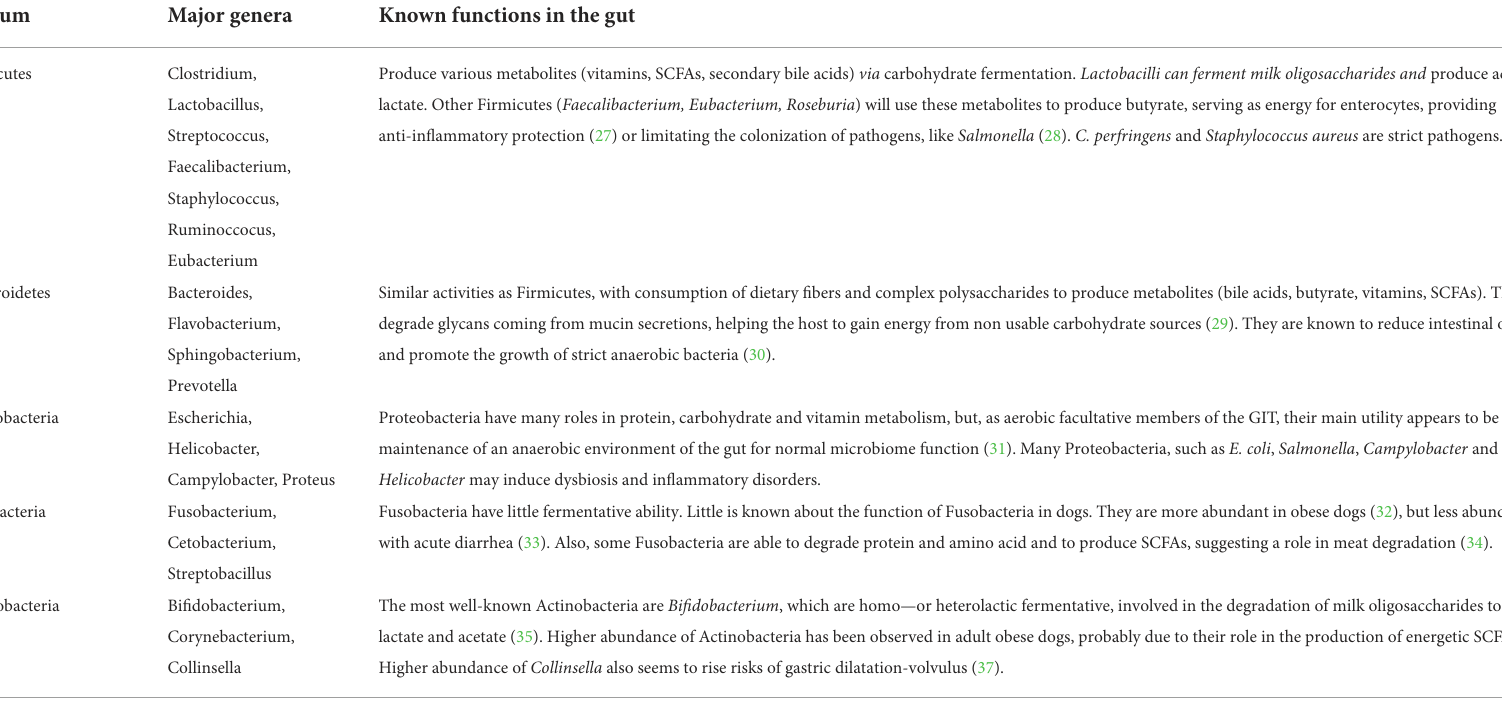
TABLE 1 Major functions of the five main phyla of the growing dog gut